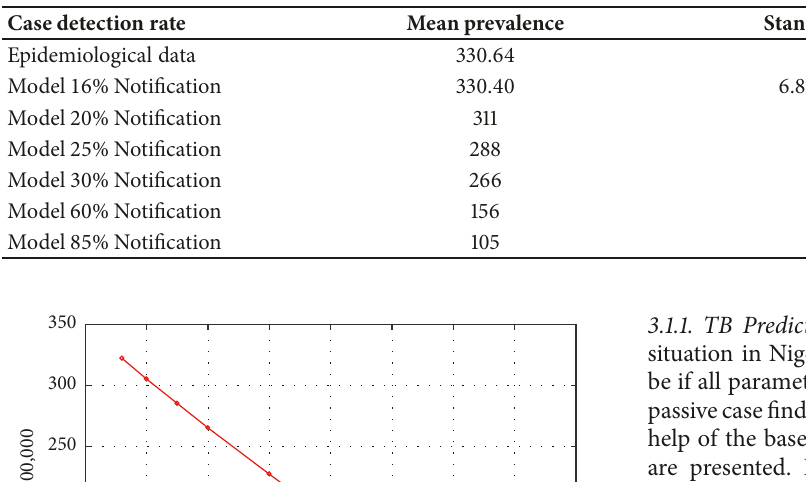
Table 2: Summary of the mean prevalence of data and model simulations, as well as 𝑅 2 of the fitting.